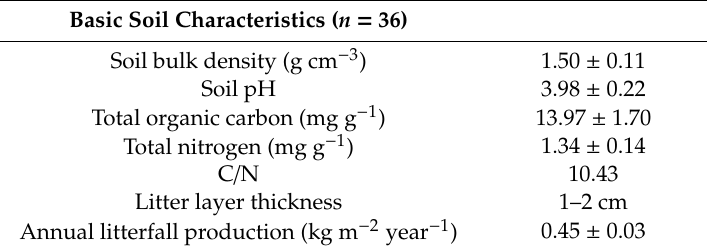
Table 1. Basic soil characteristics in the studied camphor